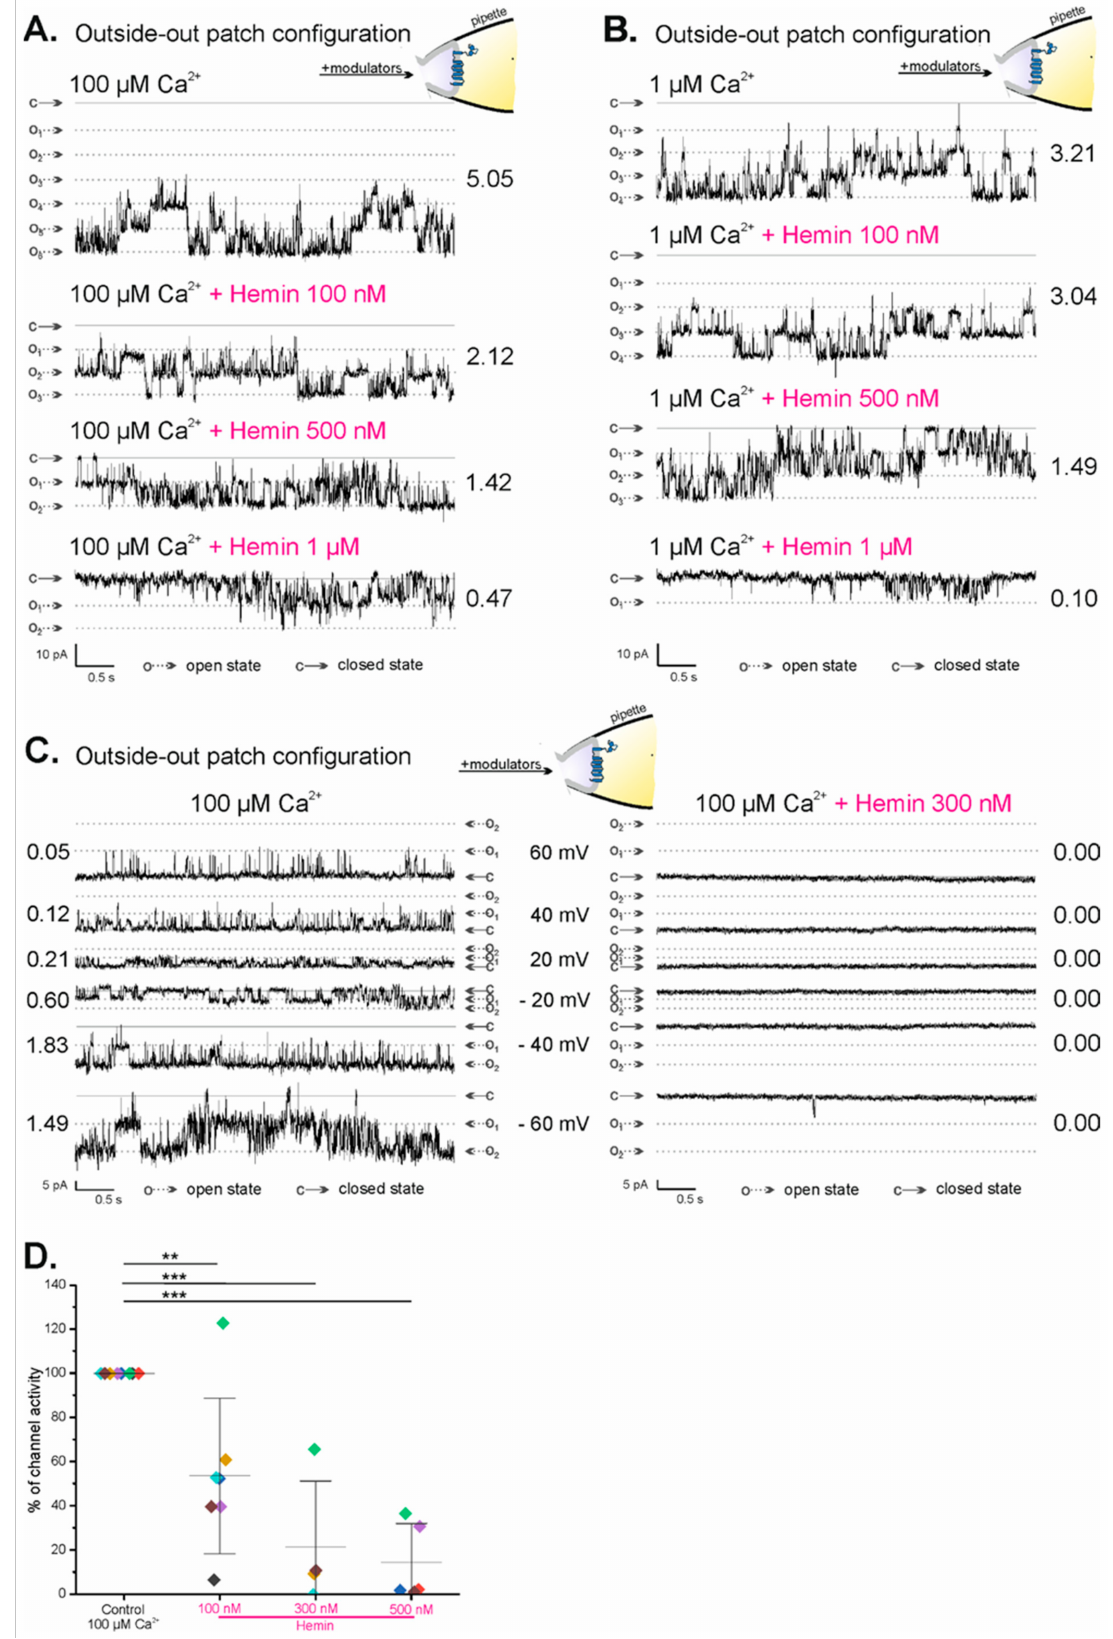
Figure 3. Regulation of the activity of the mitoBK Ca channel in outside-out configuration by hemin. ( A , B ) Changes in the open probability of the mitoBK Ca channel in multichannel patch during